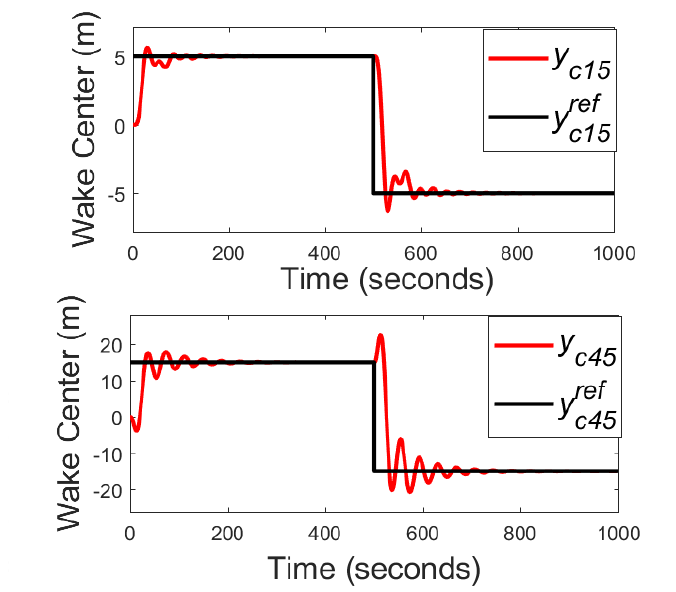
Figure 15. Wake center estimation for upwind turbines WT 1 and WT 4